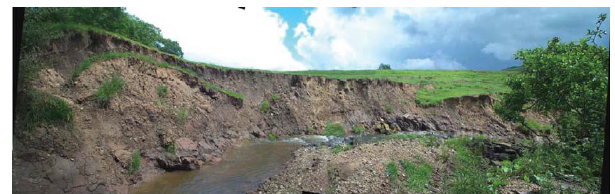
Figure 2. View looking upstream at a steep, 3m high, near verti- cal bank of unconsolidated sediment exposed along Glaisdale Beck. This is at the distal end of a large hillslope failure